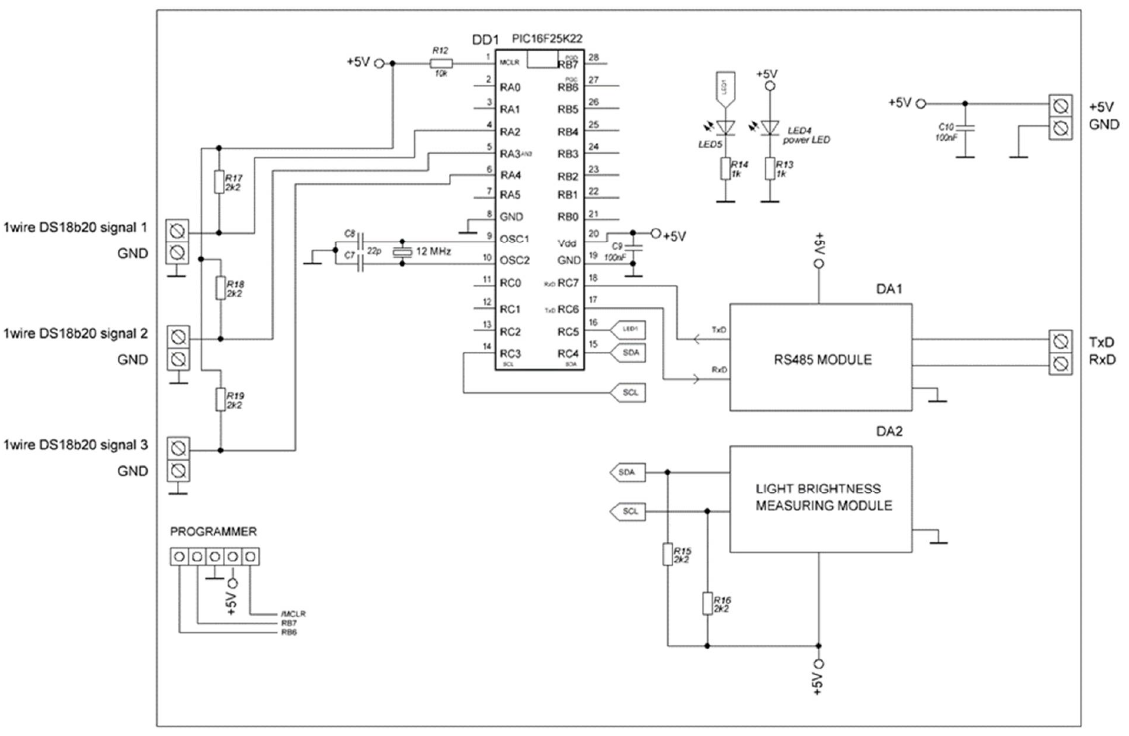
Figure 2. Schematic diagram of electronic system for monitoring operating parameters of solar power plants.